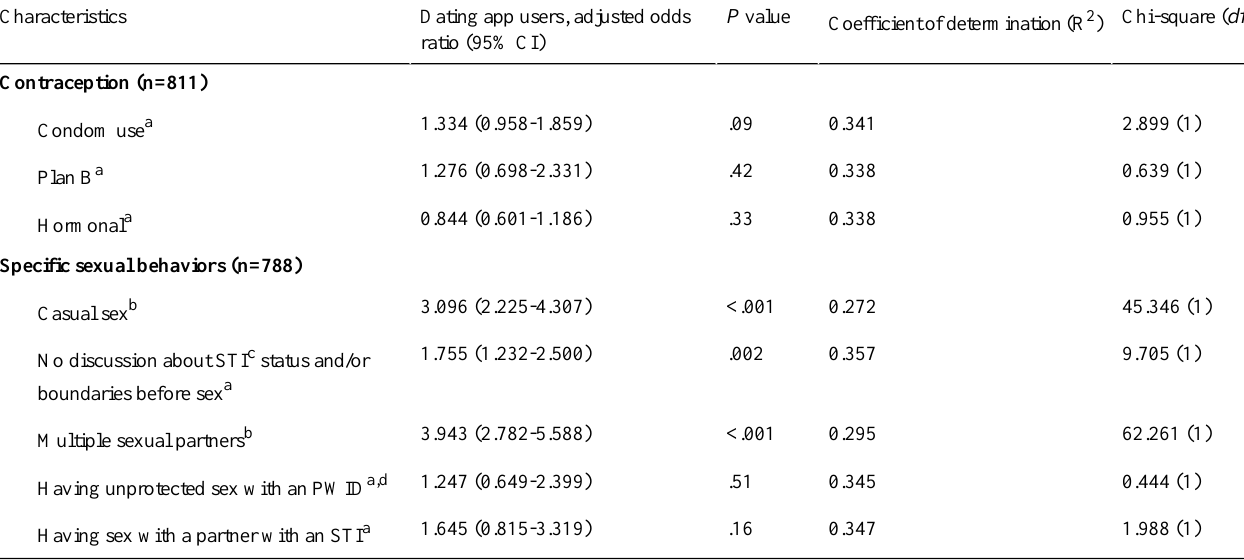
Table 3. Multivariate logistic regression models of geosocial networking dating app use and sexual